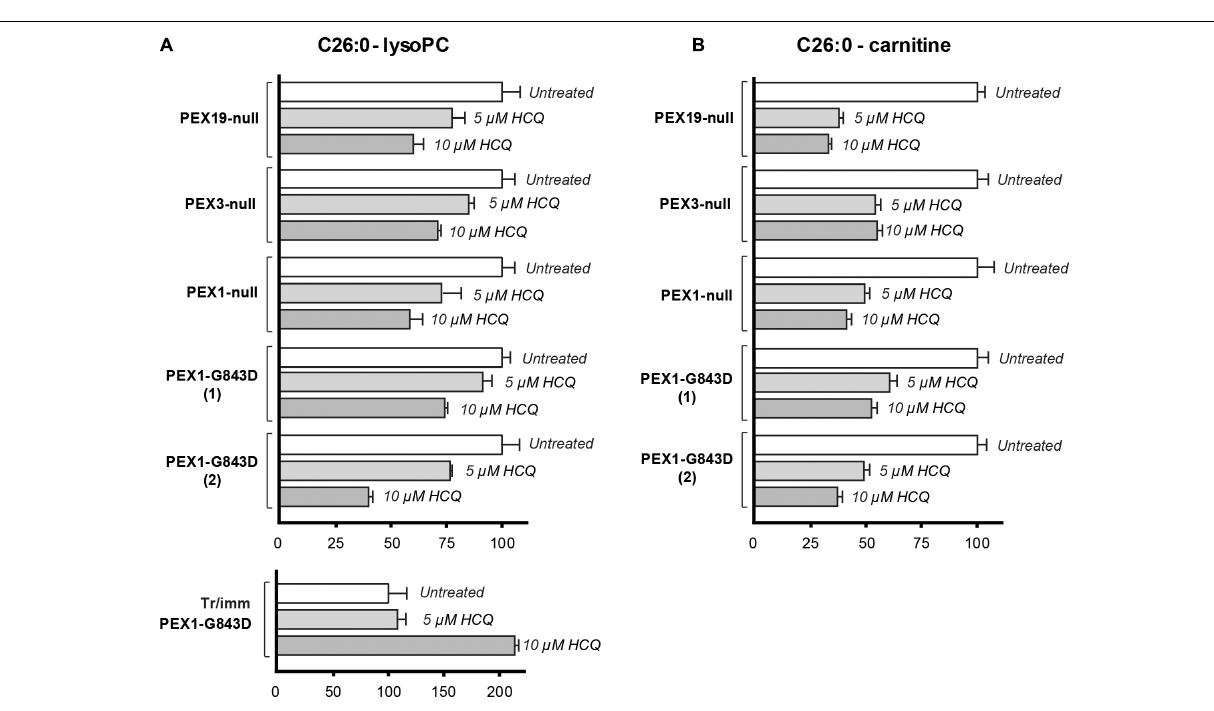
FIGURE 6 | Effect of HCQ on cellular levels of VLCFAs. C26:0-lysophosphatidylcholine (C26:0-lysoPC) levels (A) and C26:0-carnitine levels (B) measured in untreated primary PEX1-null fibroblasts, two primary PEX1-G843D fibroblasts, primary PEX3-null fibroblasts, primary PEX19-null fibroblasts, tr/immPEX1-G843D cells and in the same cells after incubation with 5 or 10 µ M hydroxychloroquine (HCQ) for 7 days. Levels in the treated cells are expressed as percentage of the mean of the levels in the corresponding untreated cells (set as 100%). Experiments were performed in duplicate; error bars represent